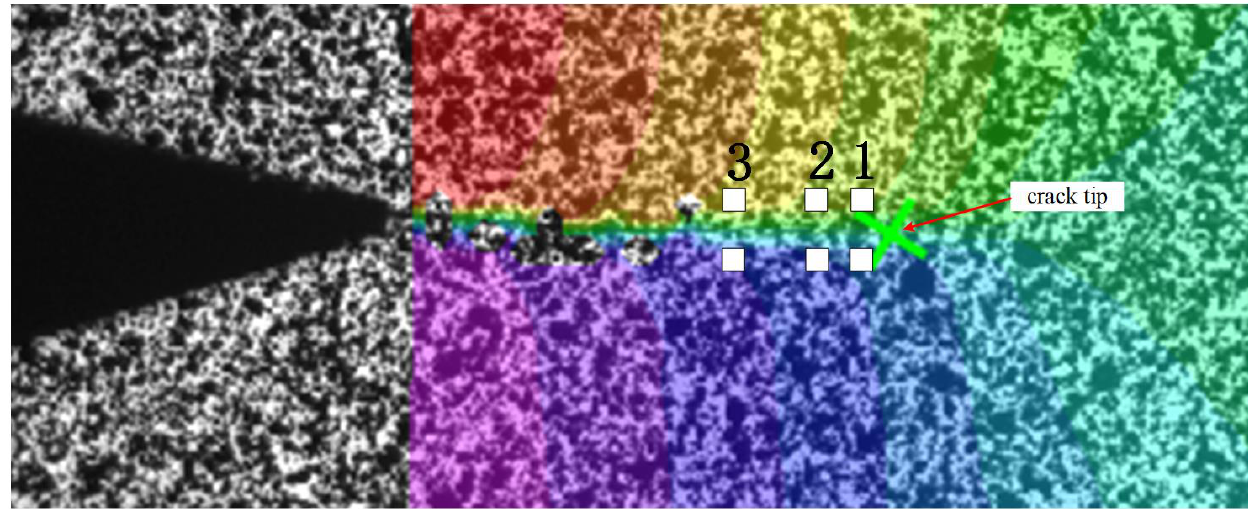
Figure 6. Virtual extensometers’ measuring point arrangement. (The three numbers represent three pairs of virtual extensometers)